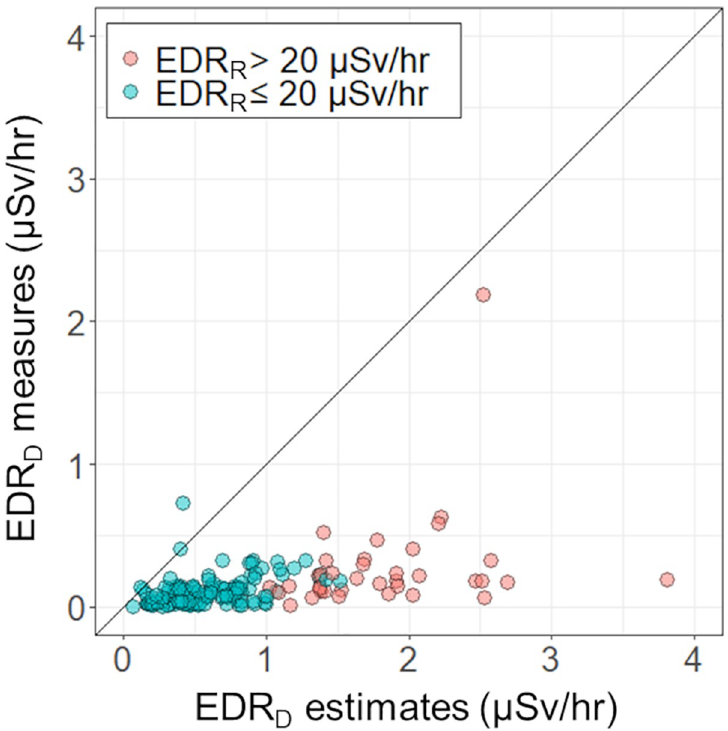
Fig 2. Comparisons between effective dose equivalent rates measured at a delayed scan time (EDR D measures, days 6–8 after 131 I administration) and estimates calculated using the EDR R based on our model (EDR D estimates). The line of equality is presented as a solid line. Red circles represent patients with EDR R > 20 μ Sv/hr who required verbal and written instructions on radiation precaution.